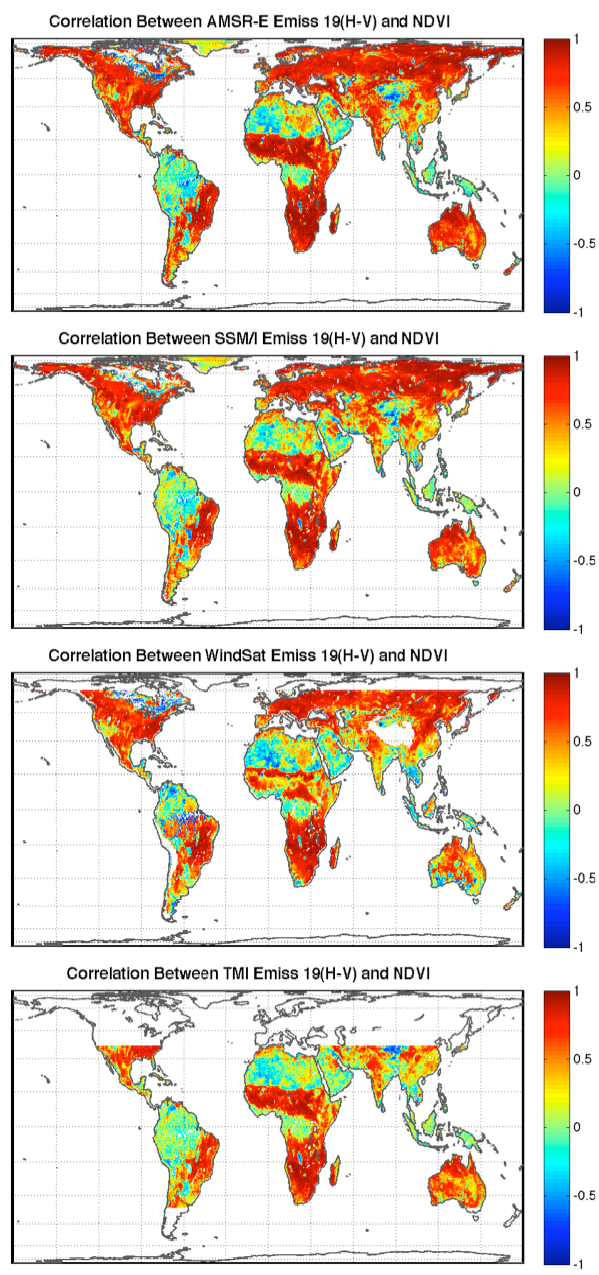
Figure 4. Correlation maps between temporal variations of e H − e V from all sensors at 19GHz with monthly NDVI values from 2003 to